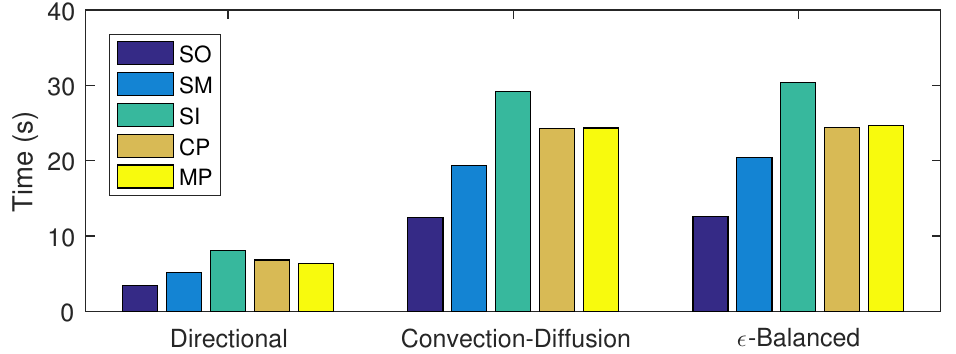
Figure 14. Mixed convection-diffusion and Burgers’ equation with 10 spatial intervals and 640 time steps. Temporal cost in seconds of the proposed methods: sequential iterative SI, classical parallel CP, and modern parallel MP, compared with the classical ones: sequential operator SO and Strang–Marchuk SM, for different decomposition